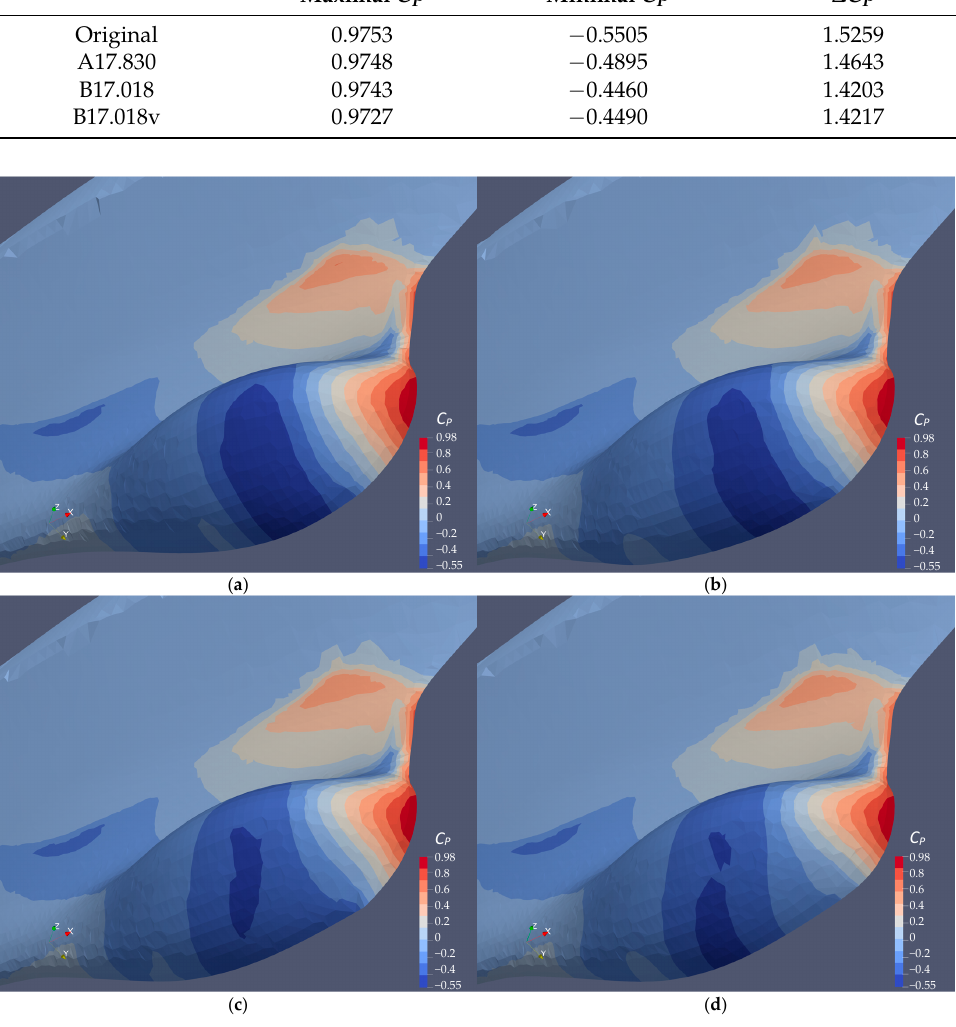
Figure 13. Distribution of pressure coefficients ( C P ) on bow surface. ( a ) Original Sonar dome, ( b ) A17.830, ( c ) B17.018 and ( d ) B17.018v. Since the flow separation area behind the sonar dome back slope is observed to be smaller for A17.830, B17.018 and B17.018v than the original sonar dome (Section 4.3.2,